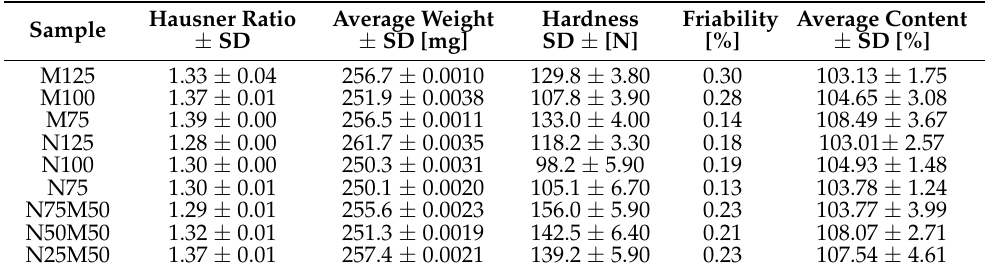
Table 2. The main characteristics of the powder blends and the matrix tablets.